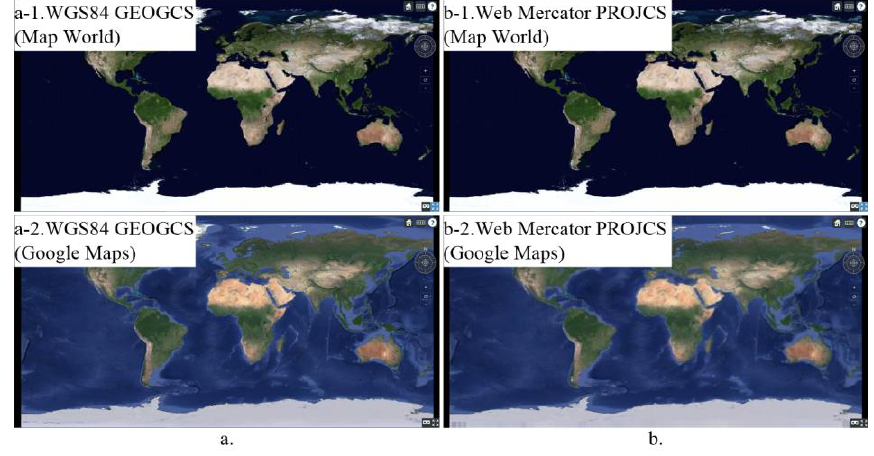
Figure 3. Comparison diagram without deformation in 2D